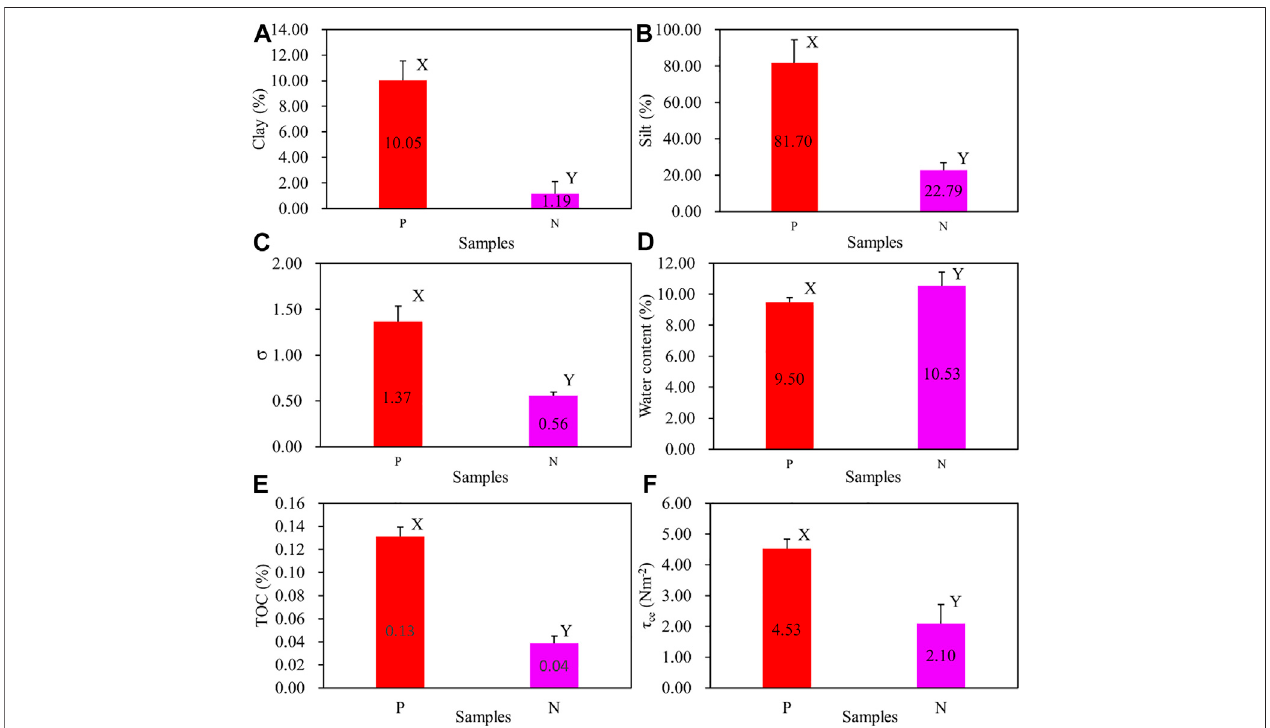
FIGURE 8 | Comparison of sediment properties between hummocky patches and surrounding areas. P represents the hummocky patches (red stripes), and N represents the surrounding fl at (purple stripes). Error bars show the standard deviation of the EPS content. Letter (X or Y) on top of the bars denotes the results of the tests, indicating that there is a signi fi cant difference between sediment from hummocky patches and nearby seabed ( p < 0.001).